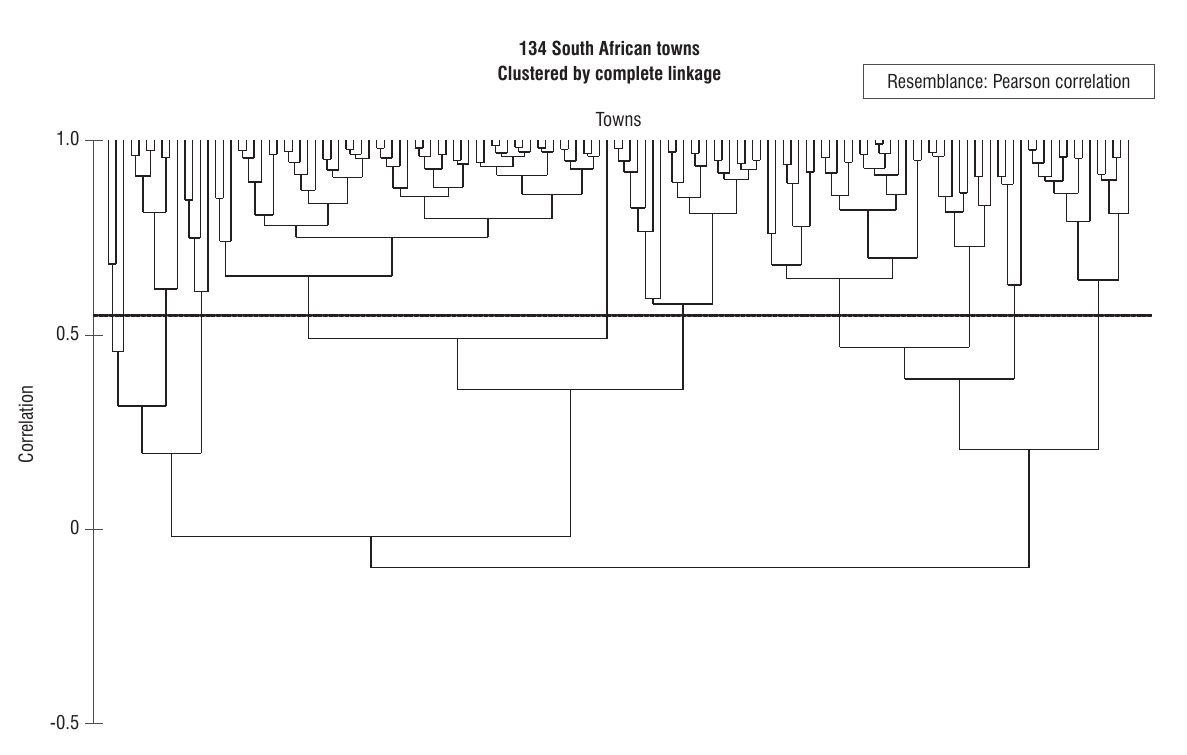
The enterprise architecture similarity dendrogram of 134 South African towns. Clusters 1 to 8 with four or more towns per cluster are identified at a correlation coefficient level of